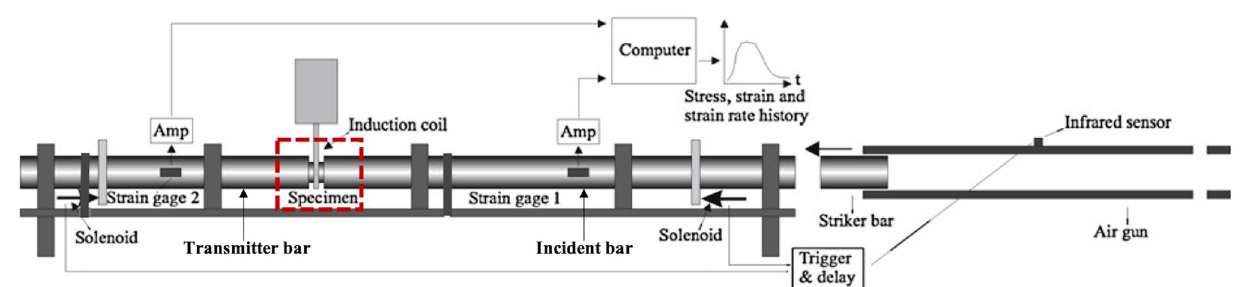
Fig. 1 Schematic of SHPB setup used to perform high strain rate compression (adapted with permission from Kajberg and Sundin [34])